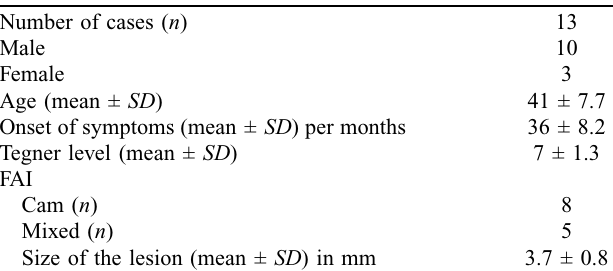
Table 1. Baseline parameters of the patients participated in the study.